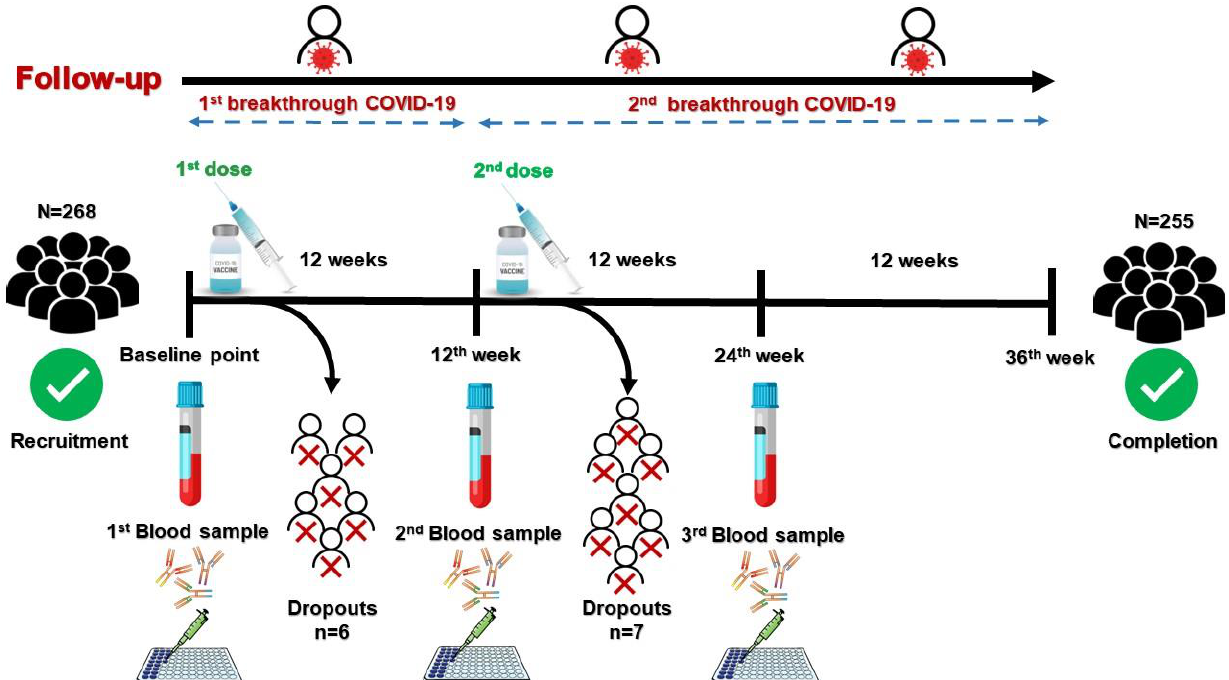
Figure 1. A schematic illustration of study design and flow. At the baseline point, healthcare workers (HCWs) were recruited and assessed for eligibility criteria. Medical history was taken, and baseline blood samples were withdrawn from 268 HCWs who were eligible for participation. Participant HCWs then received the 1st dose of vaccination. Participants were followed up for 12 weeks. Adverse reactions to the 1st dose of the vaccine, the incidence of breakthrough COVID-19 infection, and dropouts were reported during the first 12-week follow-up period. At the 12th-week time point, a 2nd blood sample was withdrawn before the participants received the 2nd dose of the vaccine. Participants were followed up for another 12 weeks. Adverse reactions to the 2nd dose of vaccine, the incidence of breakthrough COVID-19 infection, and dropouts were reported during the second 12-week follow-up period. At the 24th-week time point, a 3rd blood sample was withdrawn. Participants were followed up for another 12 weeks. Incidence of breakthrough COVID-19 infection and dropouts were reported during the third 12-week follow-up period. At the 36th week time point, 255 HCWs completed the study. Serum levels of anti-spike IgG antibody were measured from withdrawn blood samples by enzyme-linked immunosorbent assay. All dropouts were excluded from the analysis.